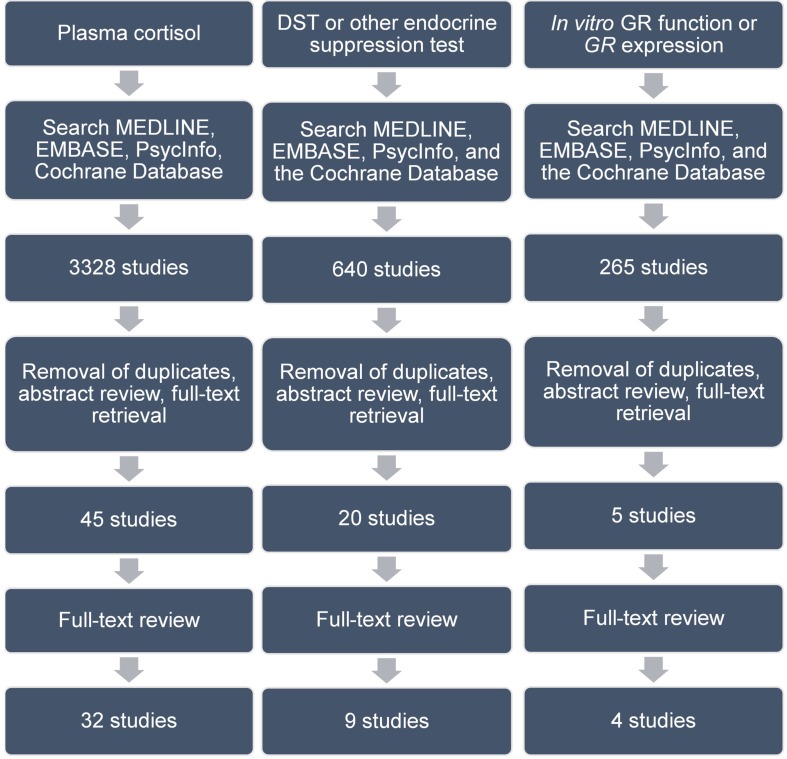
Search strategy and article review process. Details of this are found in text. Abbreviations are as follows: DST, dexamethasone suppression test; GR, glucocorticoid receptor.